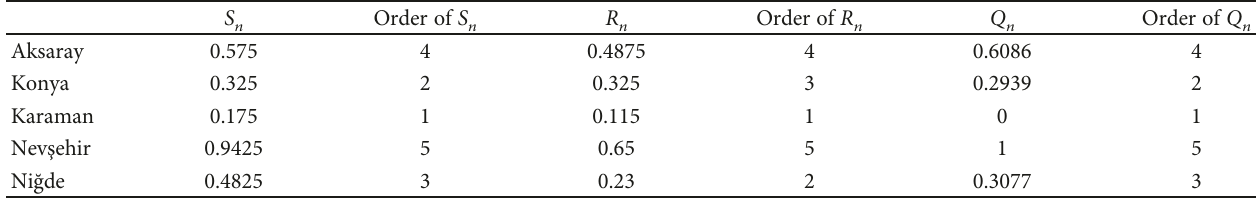
, R , Q , and decreasing order. n n n